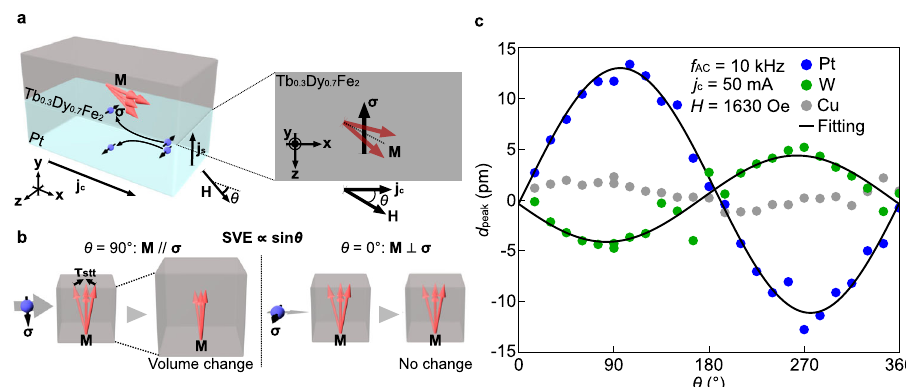
Fig. 4 Field-direction dependence of spin-current induced mechanical vibration. a A schematic illustration of the fi eld-direction dependence measurement. θ denotes the relative angle between H and j c . b A schematic illustration of the SVE when M || σ (left panel) and M ⊥ σ (right panel). The spin-transfer torque τ stt / M ´ ð M ´ σ Þ decreases (increases) the M fl uctuation when σ is antiparallel (parallel) to M , causing the volume expansion (shrinkage) of the Tb 0.3 Dy 0.7 Fe 2 fi lm. c The θ dependence of d peak for the Pt/Tb 0.3 Dy 0.7 Fe 2 (blue plots), W/Tb 0.3 Dy 0.7 Fe 2 (green plots), and Cu/ 1630